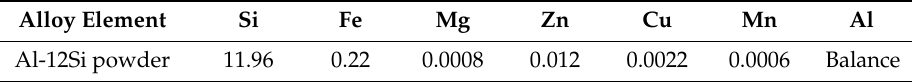
Table 1. Chemical composition of the Al-12Si powder material (wt.